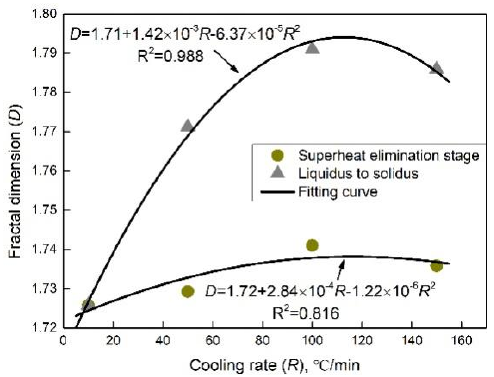
Figure 8. Fractal dimension at different cooling rates.